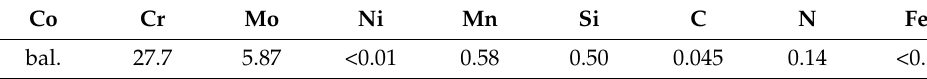
Table 1. Chemical composition of CoCrMo alloy